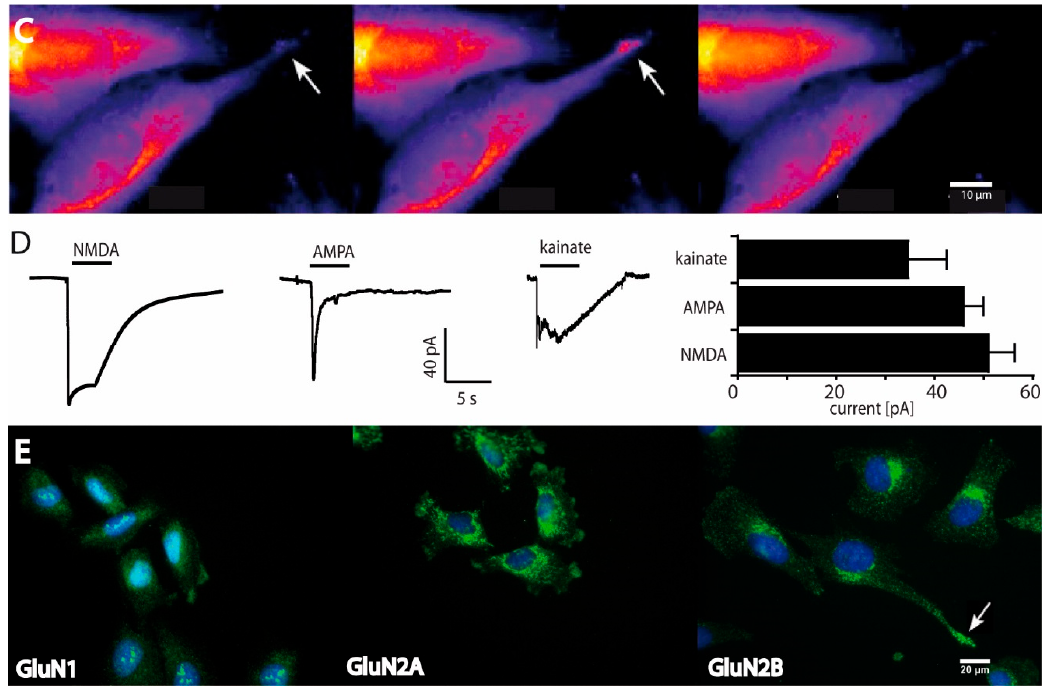
Figure 1. LN229 glioblastoma cells express functional NMDARs. ( A ) Ca 2+ -imaging of LN229 cells labeled with Fluo-4 AM displayed in ~50% of the cells a significant increase in relative fluorescence after glutamate/glycine (100 µM Glu/10 µM Gly) treatment (20 s). As an internal control, 10 µM ionomycin was given after 90 seconds. The integrated density of two non-responding (black) and two responding (red) cells are displayed. ( B ) Representative image of nuclear Ca 2+ -signals in four cells responding to Glu/Gly application (20 seconds before and after application). Scale bar 20 µm. ( C ) Images of Ca 2+ -signal oscillations in cell extensions (white arrows) 1, 4 and 10 seconds after Glu-application. Scale bar 10 µm. ( D ) Agonist-mediated traces and maximal inducible currents ( I max ) of kainate (100 µM), AMPA (100 µM) and NMDA (100 µM) analyzed by patch-clamp measurements (n = 22). Values of the I max represent means ± SEM. ( E ) Immunostaining for GluN1, GluN2A and GluN2B NMDAR subunits with anti-GluN1, anti-GluN2A and anti-GluN2B (FITC, green) merged with DAPI (blue). GluN2B subunit expression in cell lamellipodia is indicated by white arrow. Scale bar 20 µm.